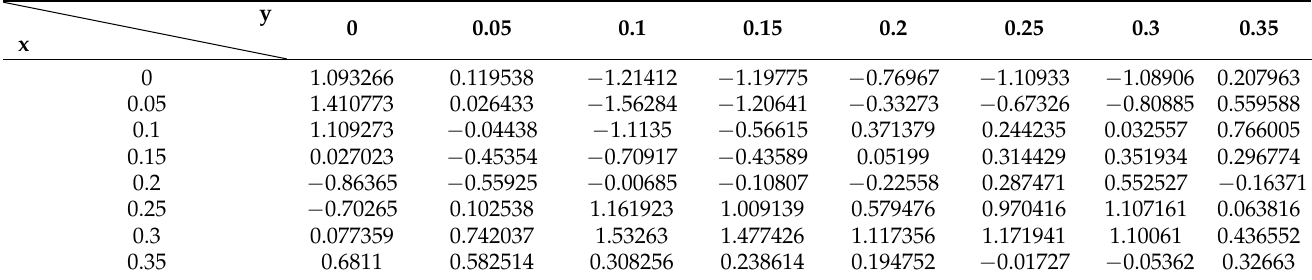
Table 2. Regenerated two-dimensional discrete data.